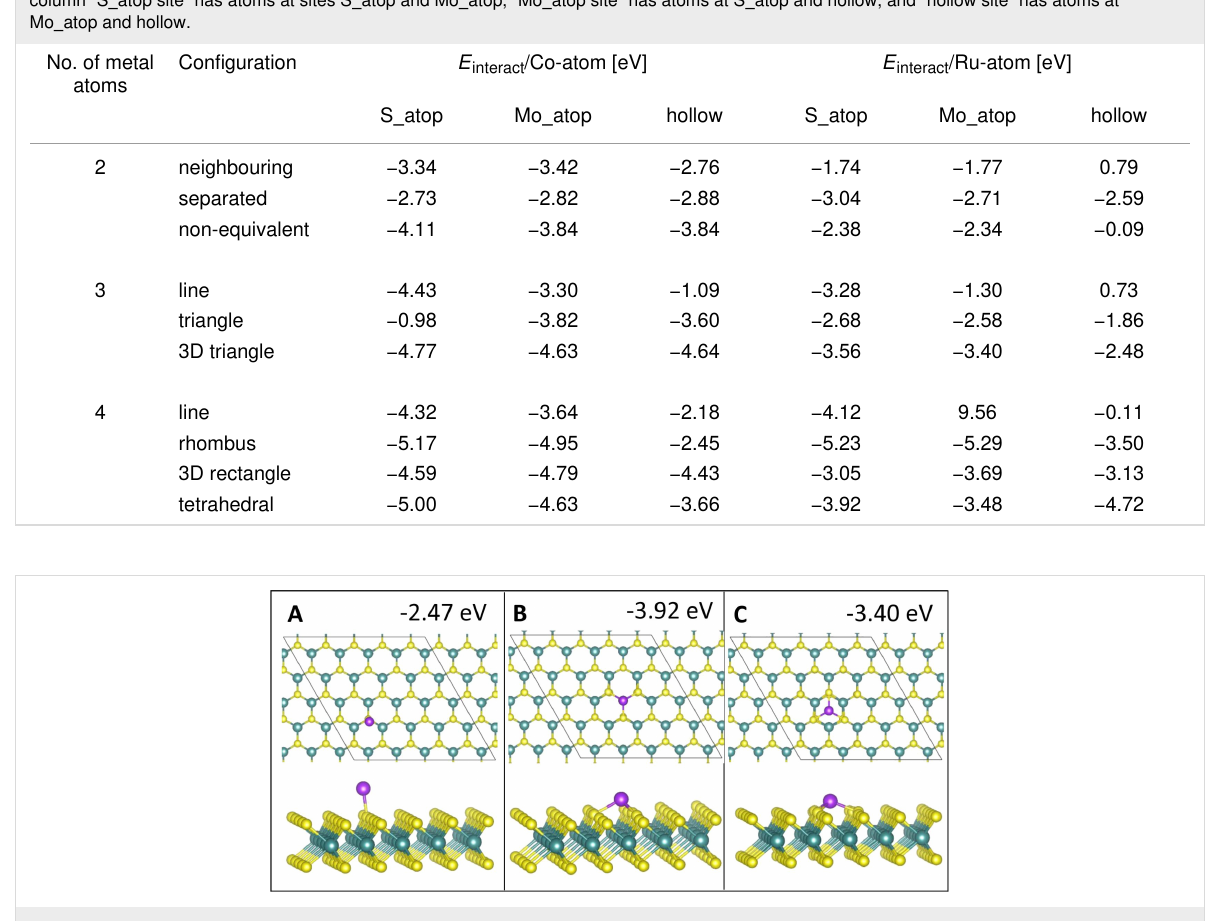
Figure 2: Atomic structure and energies of Ru 1 adsorption modes on perfect MoS 2